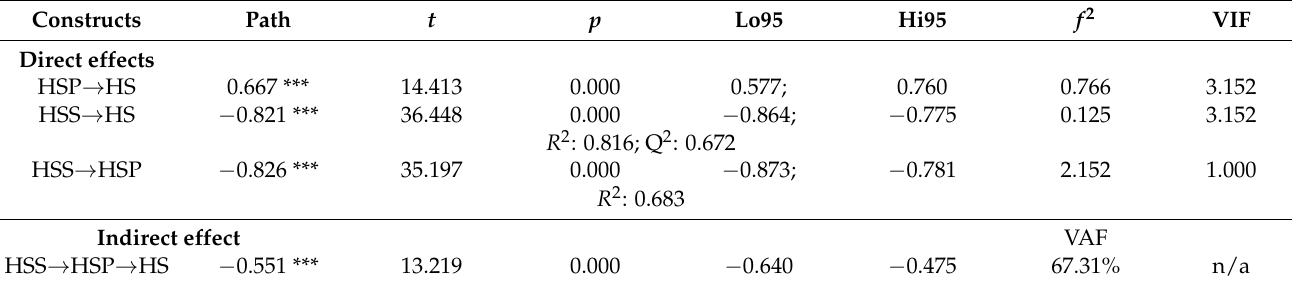
Table 9. Full sample